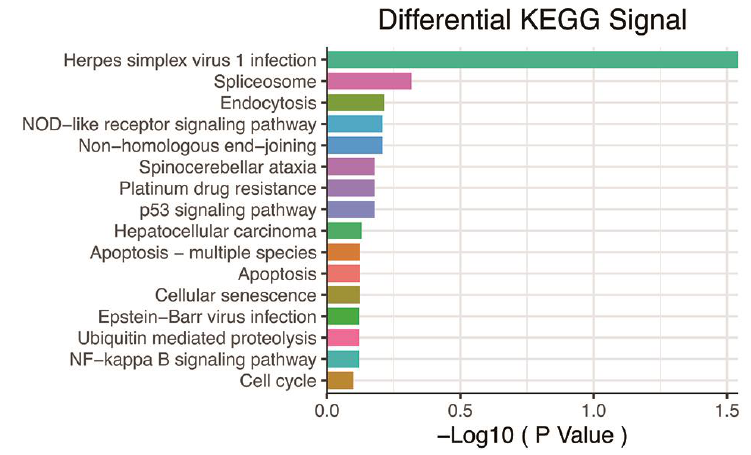
Figure 3. KEGG pathway analysis based on 784 genes with p < 0.05 and |r| > 0.6. KEGG: Kyoto Encyclopedia of Genes and Genomes.